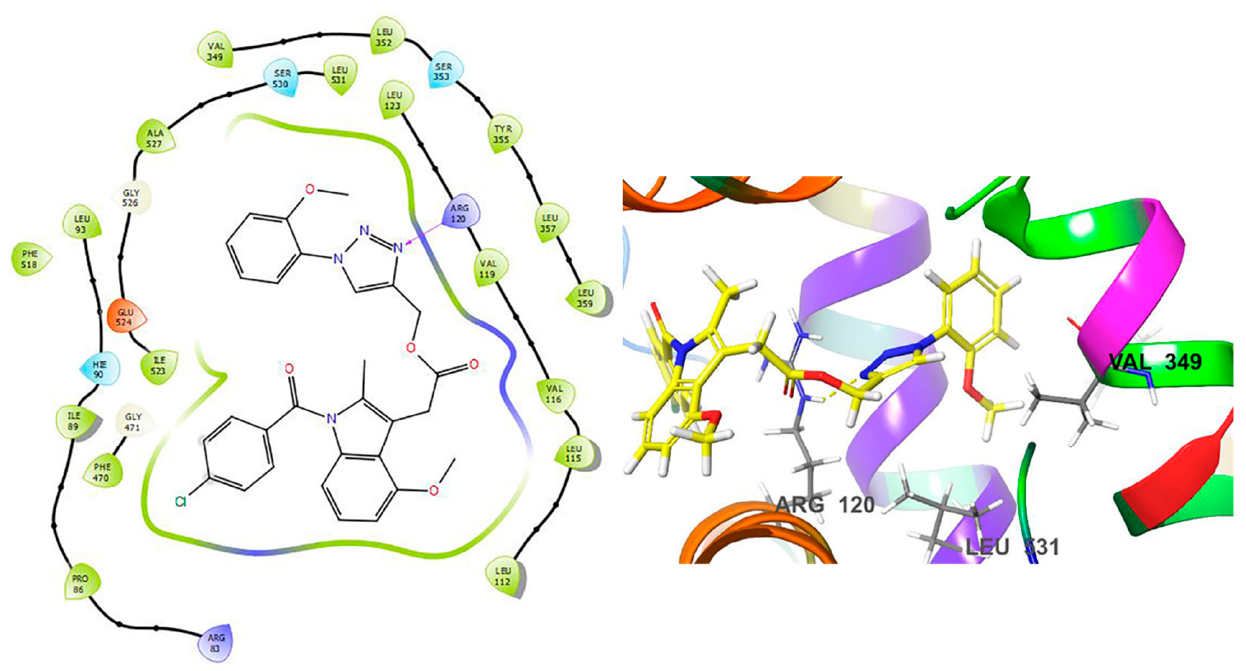
Figure 6. Binding interactions and docked pose of compound 5e in the COX-1 crystal structure, PDB: 3N8W. Critical interactions with Arg120, Leu531, and Val349 are shown.